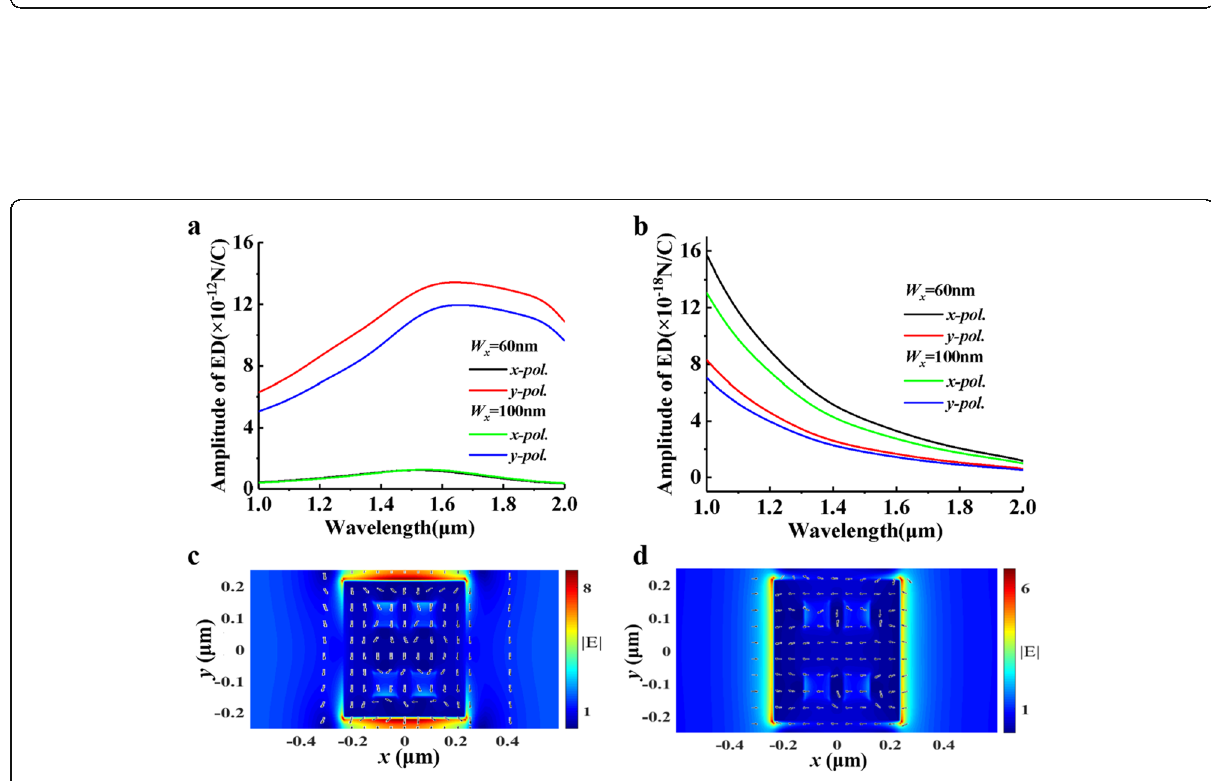
Fig. 3 a The intensity of ED resonances. b The intensity of MD resonances. c, d The electric field intensity and vectors of x-pol. and y-pol. incidence,